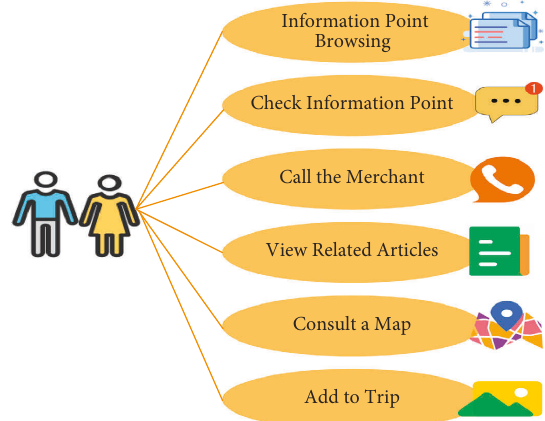
Figure 1: Pretour service demand use case.